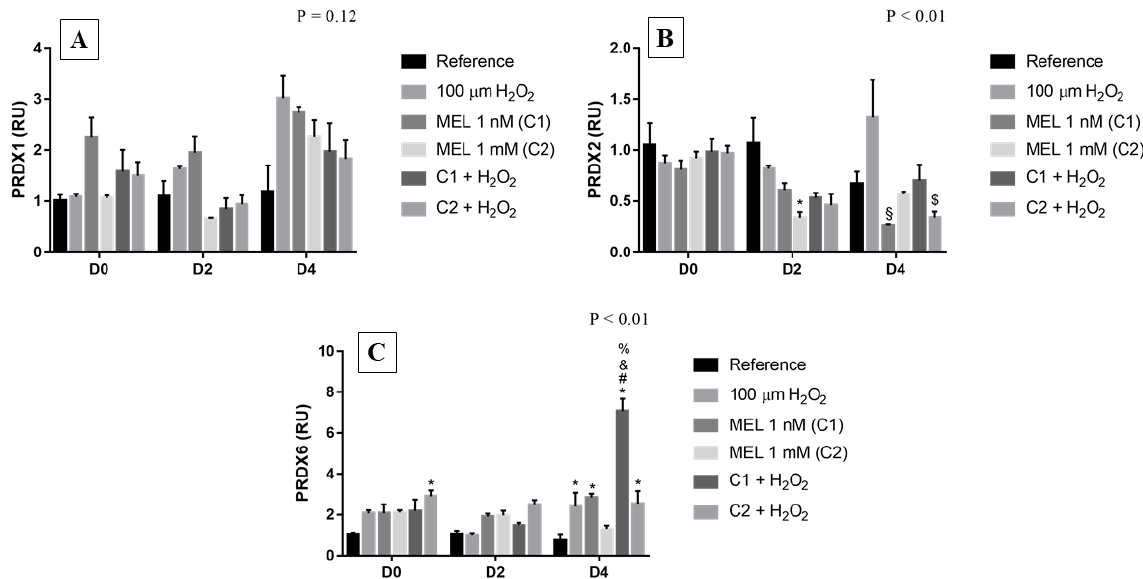
Figure 4. Relative expression of PRDXs in K562 erythroid cells: ( A ) Peroxiredoxin 1 ( PRDX1 ) gene expression, ( B ) Peroxiredoxin 2 ( PRDX2 ) gene expression, and ( C ) Peroxiredoxin 6 ( PRDX6 ) gene expression